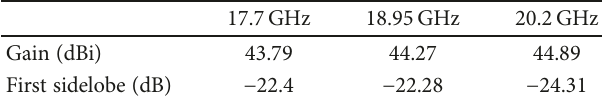
Table 2: Measured data of antenna receiving